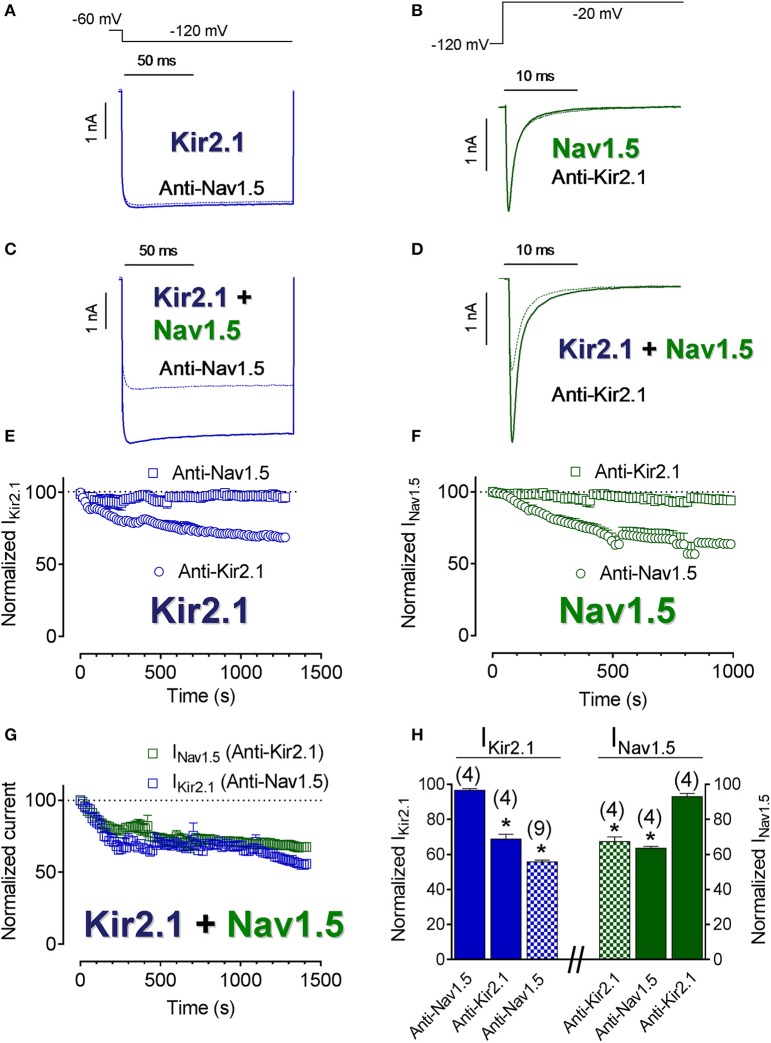
Kir2.1 and Nav1.5 channels closely interact at the cell membrane. (A–D) IKir2.1
(A,C) and INav1.5
(B,D) traces recorded by applying the protocols shown at the top in CHO cells expressing Kir2.1 or Nav1.5 channels alone (A,B) or together (C,D) in control conditions (solid lines) or after dialyzing the cell with the antibodies indicated (dashed lines). (E–G) Normalized IKir2.1 (measured at −120 mV) (E,G) and peak INav1.5
(F,G) measured in the absence and presence of anti-Kir2.1 or anti-Nav1.5 antibodies in cells transfected with Kir2.1 or Nav1.5 channels alone (E,F) or cotransfected with both (G) plotted as a function of time. (H) Bar graphs showing the mean normalized current density values measured in each experimental group at the end of the recordings. Each point/bar represents the mean ± SEM of (n) cells of ≥ 3 preparations. In (H), *P < 0.05 vs. IKir2.1 or INav1.5 generated by Kir2.1 or Nav1.5 channels alone in the presence of anti-Nav1.5 or anti-Kir2.1 antibodies. For clarity the results of other statistical comparisons were not shown.